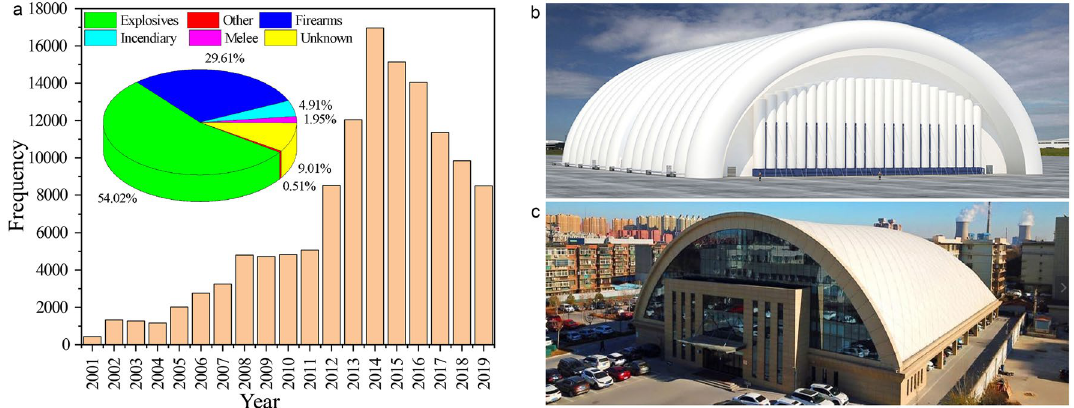
Figure 1. research motivation. ( a ) Global distribution of terrorist attacks 3 . ( b ) Mobile hangar. ( c ) Inflatable stadium.